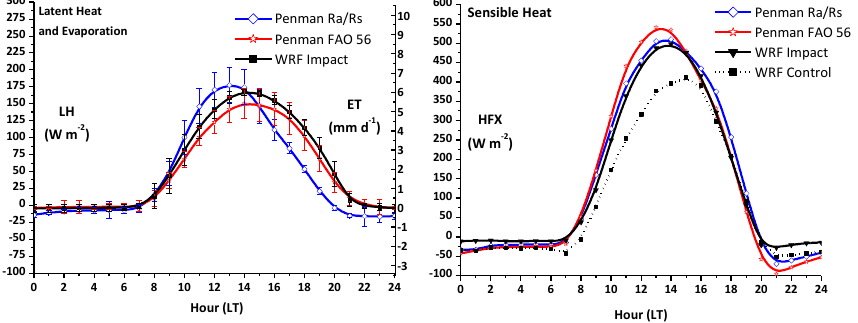
Fig. 11. Mean summer diurnal cycles of LH and HFX from WRF Impact (solid lines). Also indicated are the estimates from Penman– Monteith with R a /R s and FAO-56 Penman–Monteith (dashed lines). The left hand plot shows ET expressed in Wm − 2 (left y axis) and mmd − 1 (right axis) along with standard deviation. The right hand plot shows the HFX fluxes from WRF Impact and also the implied HFX based on the Penman estimates [calculated as the residual of the energy balance R n (Obs) − G (Obs) − LH(Estimation)]. HFX from WRF Control is also plotted to assess the diurnal differences between HFX from desert and from irrigated plantations.